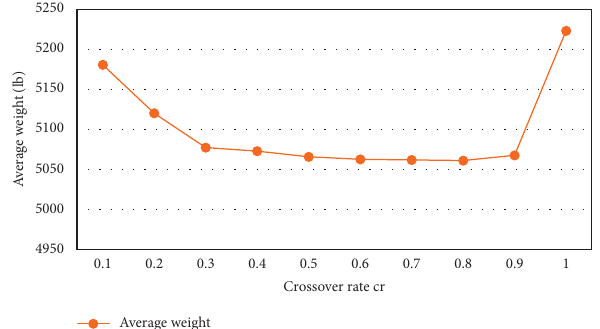
Figure 6: Effects of various values of CR on average weight of designs for the 10-bar truss using EDE with F l � 0.3 and F u �